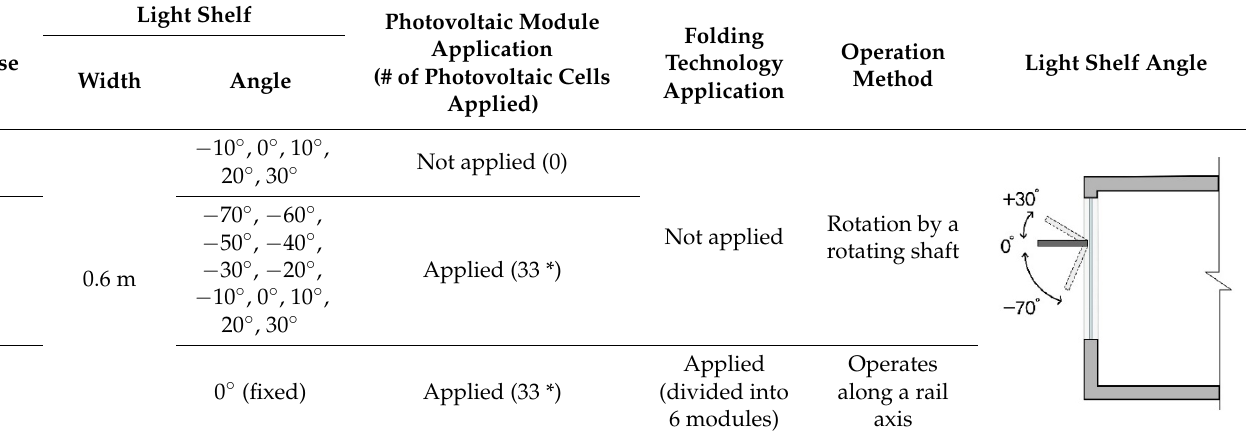
Table 4. Folding shape, light shelf angle, and photovoltaic module angle according to the width